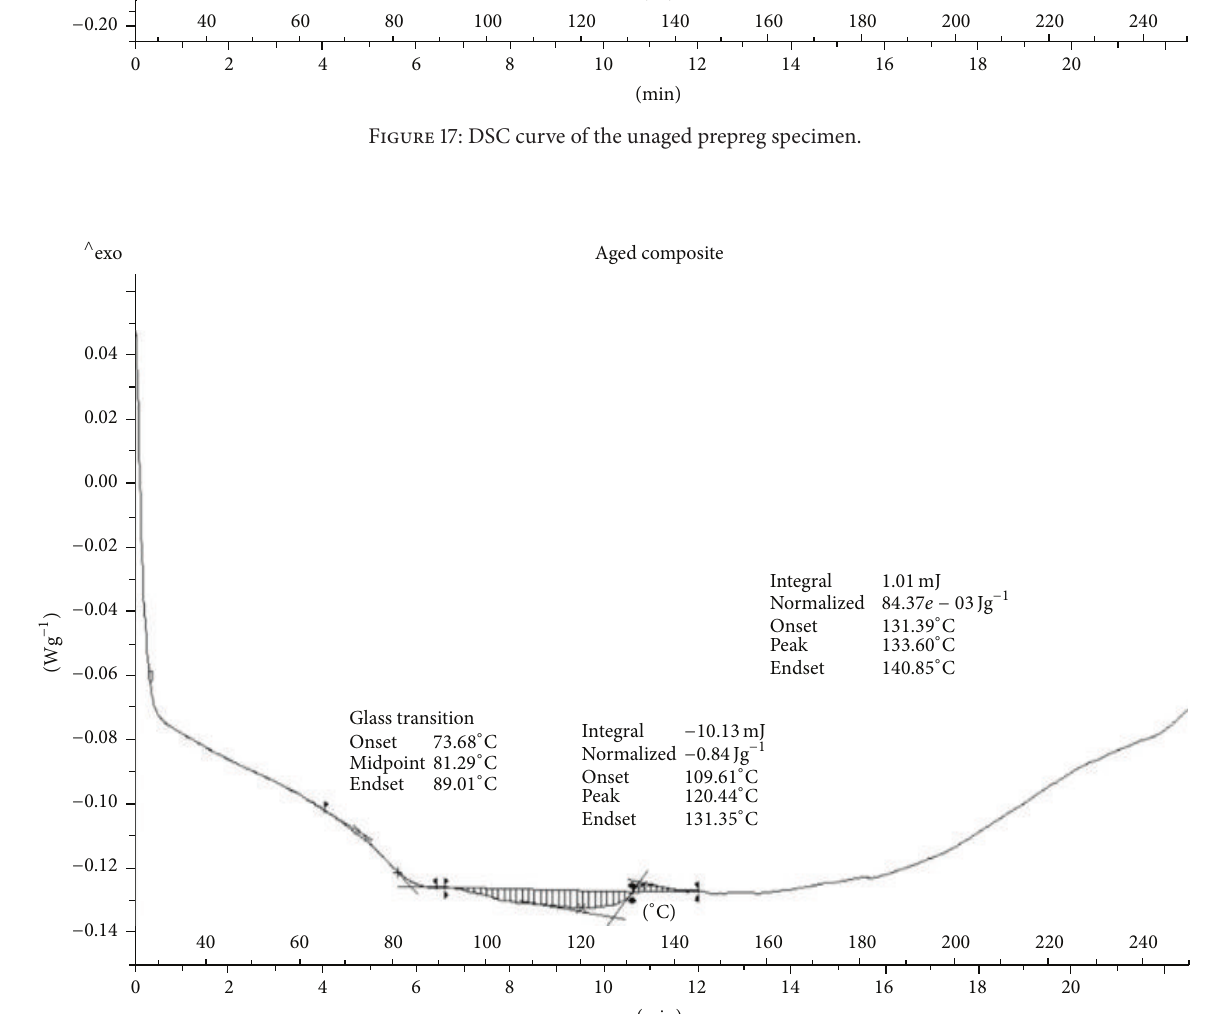
Figure 18: DSC curve of the aged prepreg